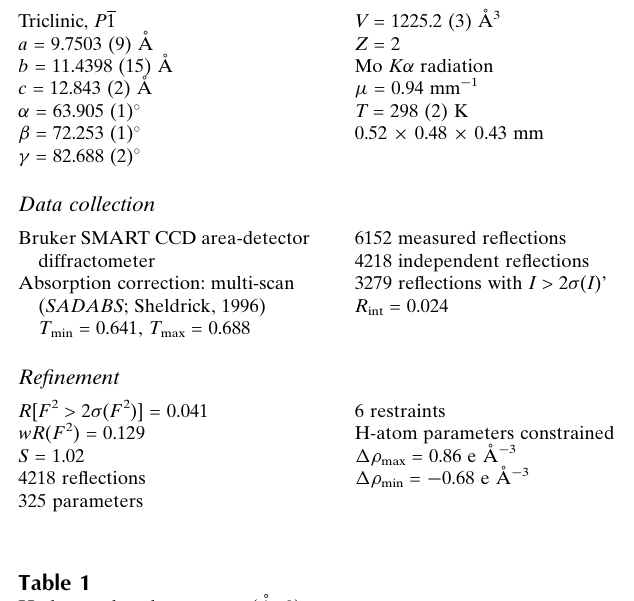
Hydrogen-bond geometry (A˚ , (cid:2)